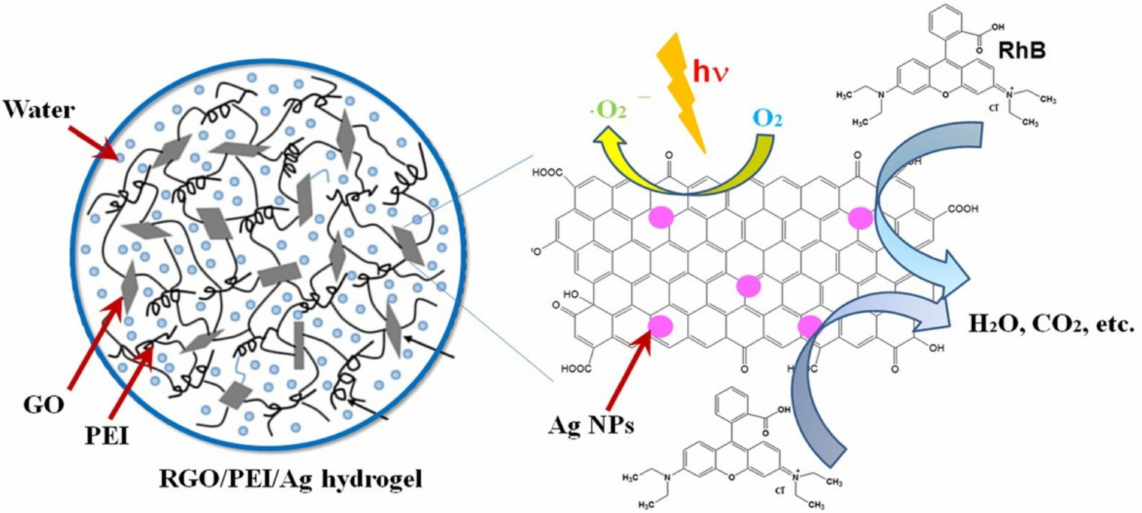
Figure 3. Mechanism of photocatalytic degradation of dyes using RGO/PEI/Ag nanocatalyst. Reprinted with permission from Ref.